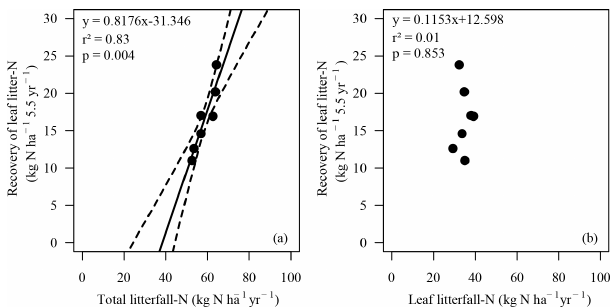
Figure 3. Recovery of leaf litter N (kgha − 1 yr − 1 ) calculated from 15 N-labeled beech litter 5.5 years after litter exchange ver- sus N flux with (a) total litterfall N and (b) with leaf litterfall N (kgNha − 1 yr − 1 ) at the study sites ( n = 7). Solid line: regres- sion line. Dotted lines: confidence bands of regression with p = 0 . 90. Spearman’s rank correlation (a) r Spear = 0 . 96, p < 0 . 001; (b) r Spear = 0 . 00, p = 1 . 0.